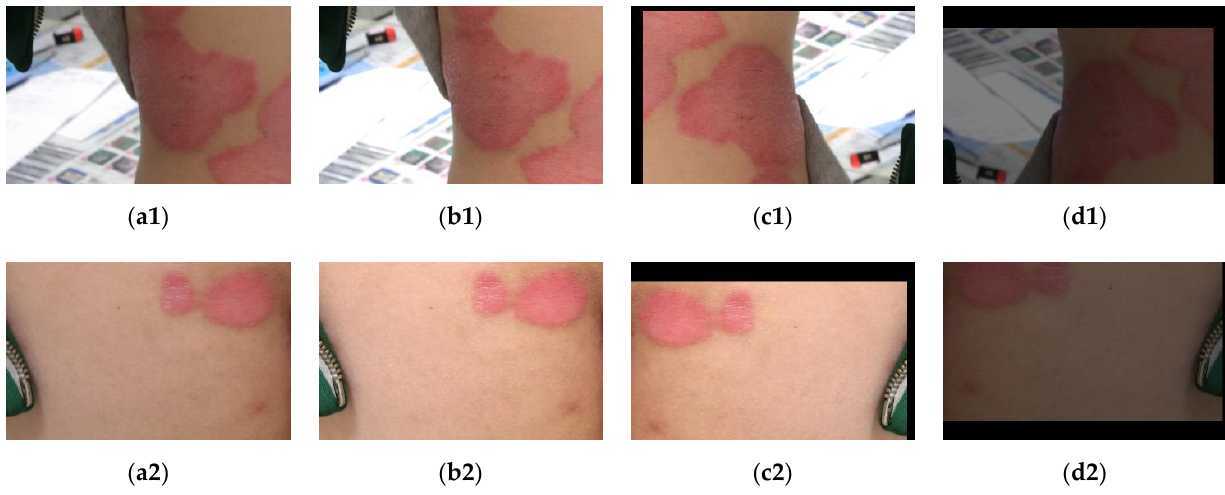
Figure 6. Examples of augmented psoriasis images for model training: ( a1 , a2 ) Original, ( b1 , b2 ) brightness adjustment, ( c1 , c2 ) flipping + brightness increasing + translation, and ( d1 , d2 ) flipping + brightness decreasing + translation.